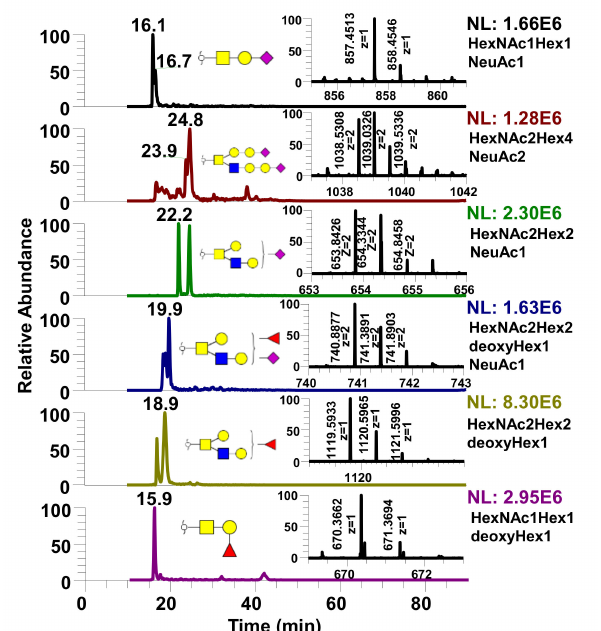
Figure 5. Extracted ion chromatograms (EIC) of various free reducing end O -glycans derived from human milk. Insets are mass spectrum of each O -glycan